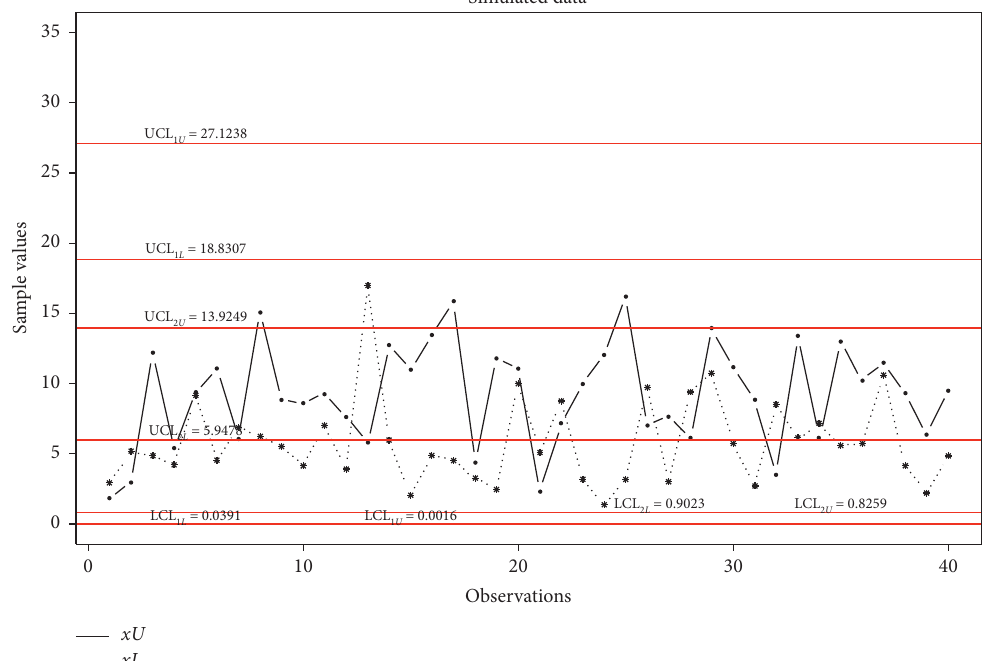
Figure 2: The existing control chart for simulated data when a k ∈ [ 1 . 5279 , 2 . 8818 ] . 2 N